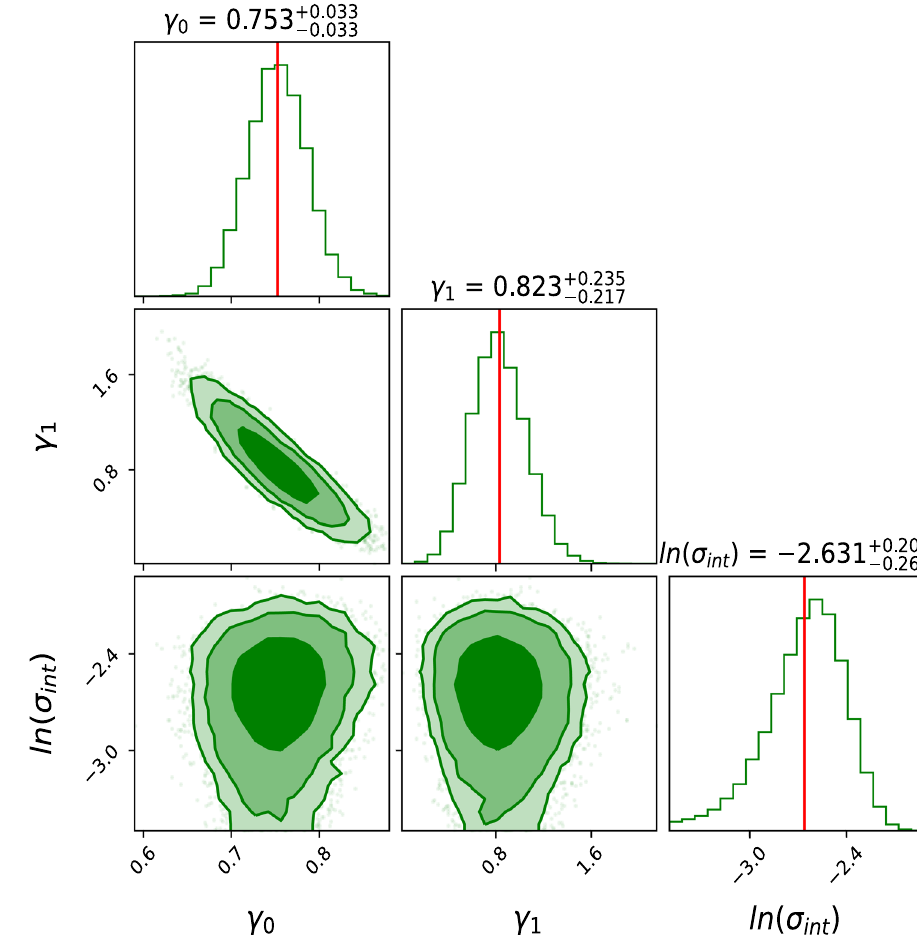
Fig. 6 For Planck ESZ dataset: constraints on the parameters γ 0 and γ 1 along with ln (σ int ) . The plots along the diagonal are the one-dimensional marginalized likelihood distributions. The contour plot represents the two-dimensional marginalized constraints showing the 68%, 95%, and 99% credible regions. These contours have been obtained using the Corner python module